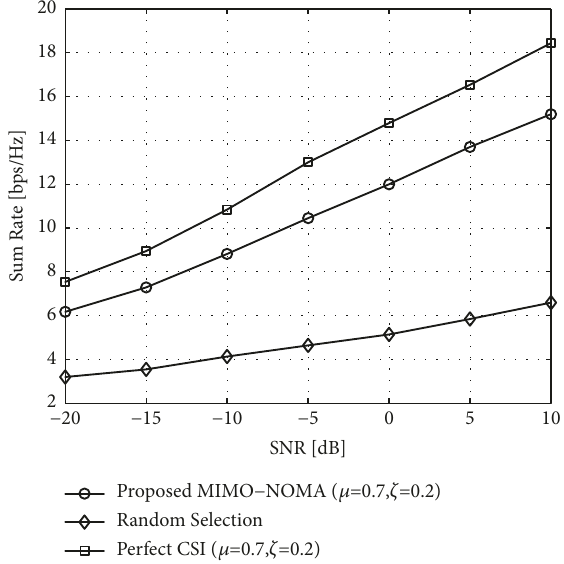
Figure 3: Comparison of sum rate performance between different schemes for MIMO-NOMA system against SNR ( 𝜇 =0.7; 𝜁